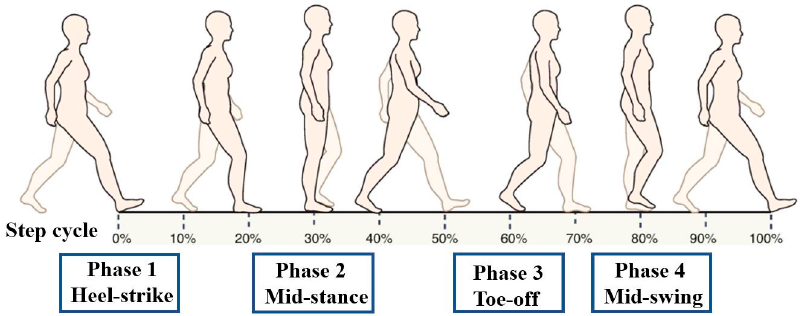
Figure 1. H-reflexes were elicited by stimuli at heel-strike, mid-stance, toe-off, and mid-swing of the stride cycle for all walking conditions. stride cycle for all walking